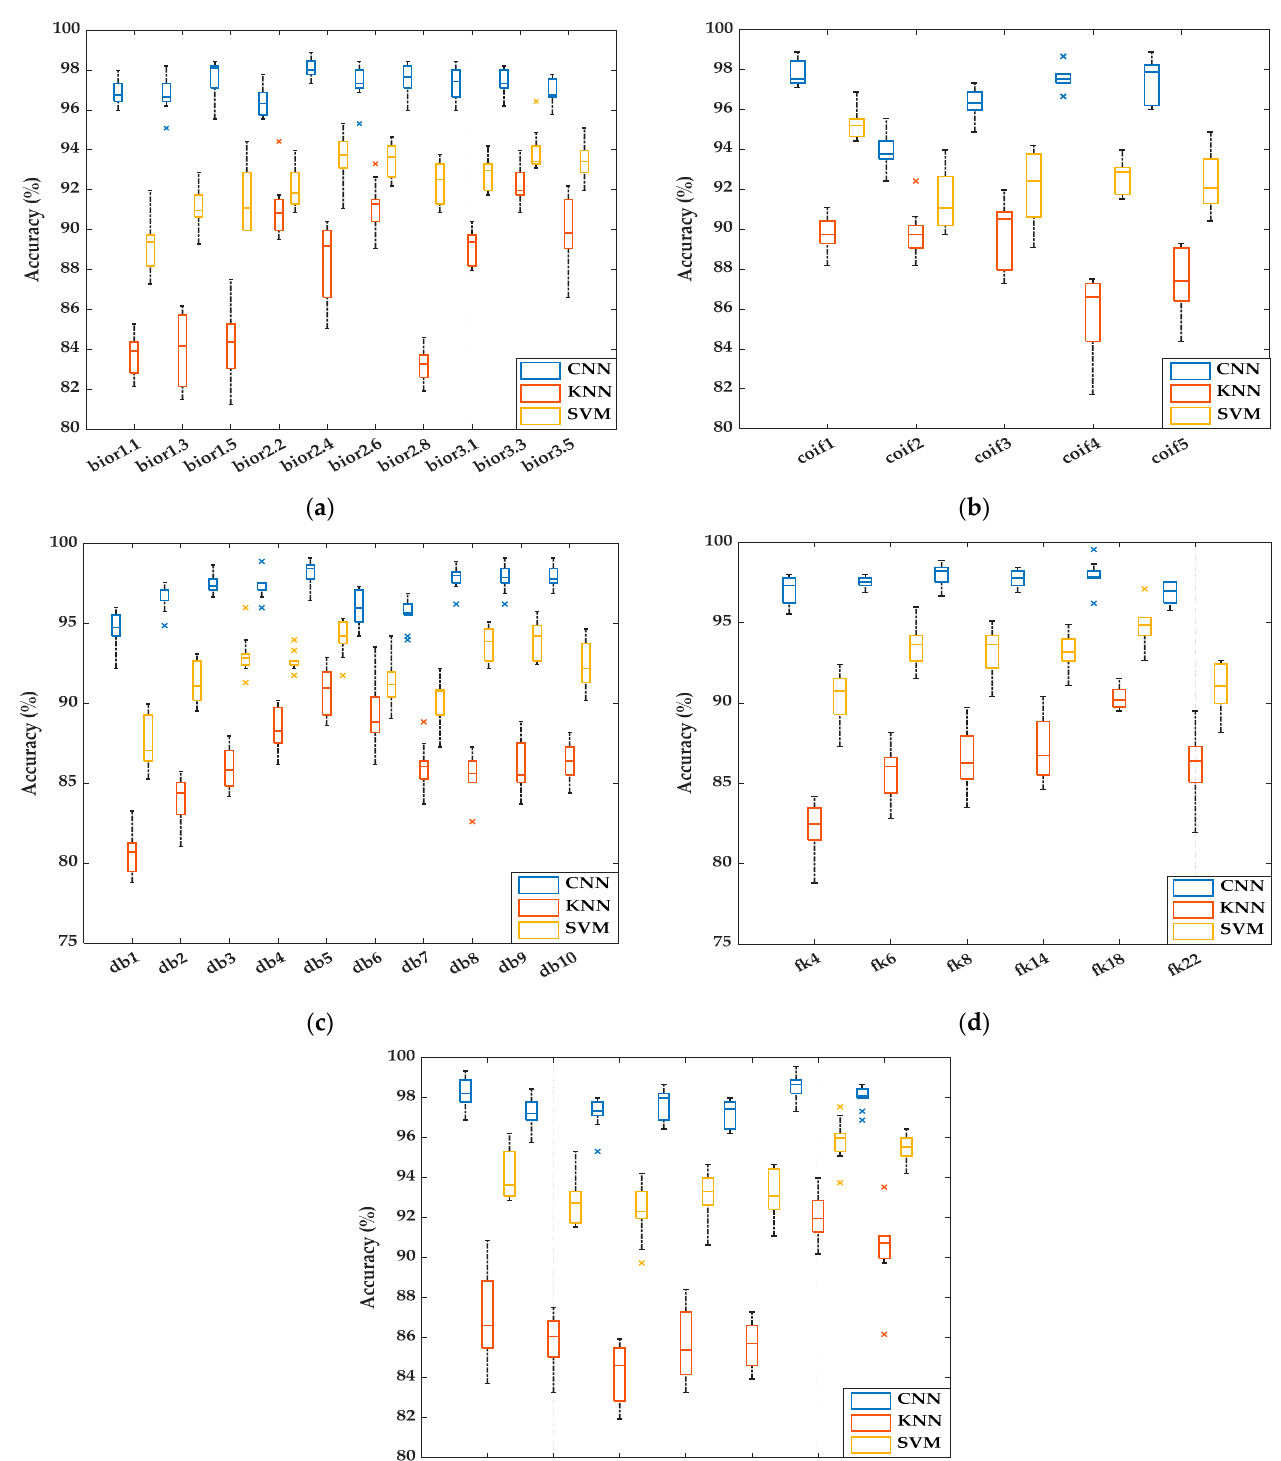
Figure 7. Performances of classifiers used in the study for the ( a ) biorthogonal, ( b ) Coiflet, ( c ) Daubechies, ( d ) Fejer–Korovkin, and ( e ) symlet wavelet families.